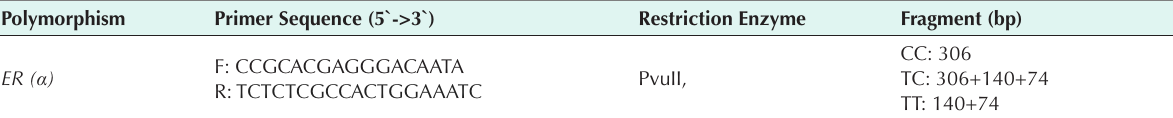
Table 1. Primer Sets and Related Restriction Enzymes Used for ER α SNP Analysis by the PCR-RLFP Method